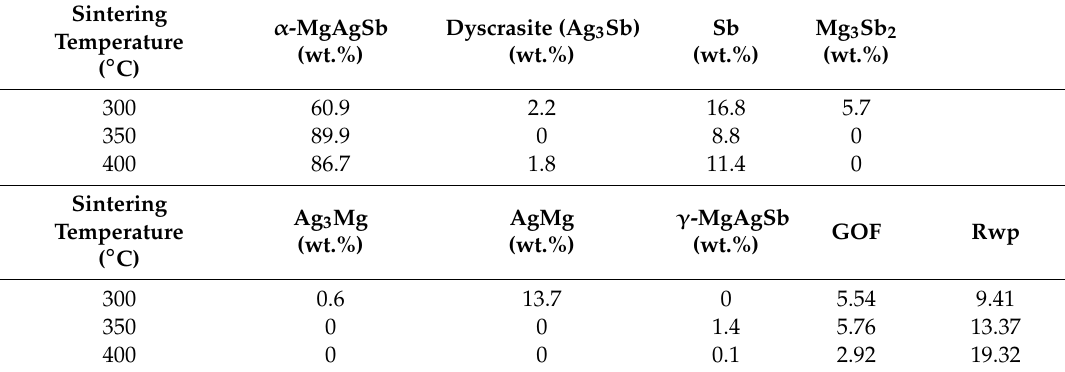
Table 3. Phase proportions in the samples obtained by Rietveld refinement for the study on sintering temperature.